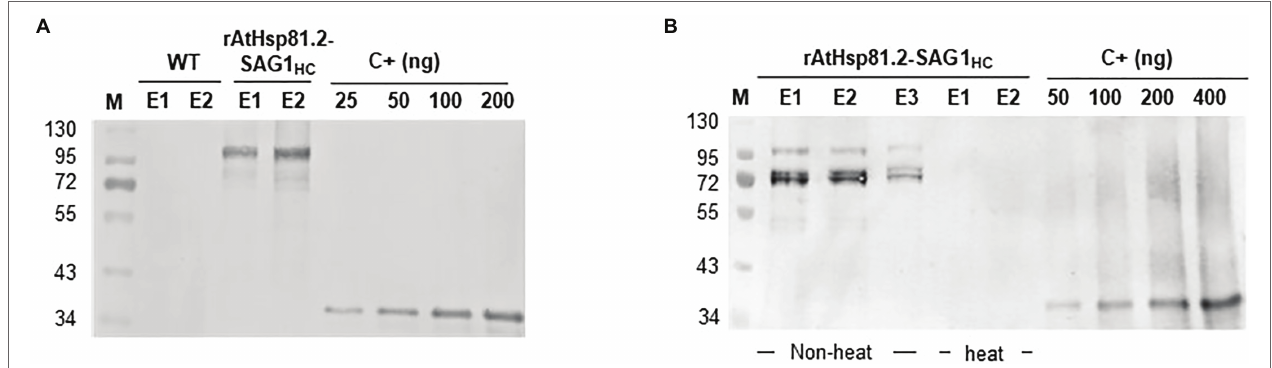
FIGURE 5 | Purification of plant-produced AtHsp81.2–SAG1 HC (rAtHsp81.2–SAG1 HC ). (A) Western blot analysis of the fraction eluted with 250 mm imidazole using anti-rEcSAG1 m polyclonal antibody. rAtHsp81.2–SAG1 HC (E1 and E2), elutes from Nicotiana benthamiana expressing AtHsp81.2–SAG1 HC ; WT (E1 and E2), elutes from non-infiltrated N. benthamiana . (B) Effect of heat incubation on the rAtHsp81.2–SAG1 HC purification procedure. rAtHsp81.2–SAG1 HC (E1, E2 and E3), elutes from Nicotiana benthamiana expressing AtHsp81.2–SAG1 HC without heat incubation; rAtHsp81.2–SAG1 HC (E1, and E2), elutes from Nicotiana benthamiana expressing AtHsp81.2–SAG1 HC after heat incubation at 65 ° C. Western blot analysis of the fraction eluted with 250 mm imidazole was carried out using an anti-rEcSAG1 m polyclonal antibody. The protein extractions were heat incubated at 65 ° C during homogenization, before the purification procedure. Lanes were loaded at equal volumes (10 μ l) for direct